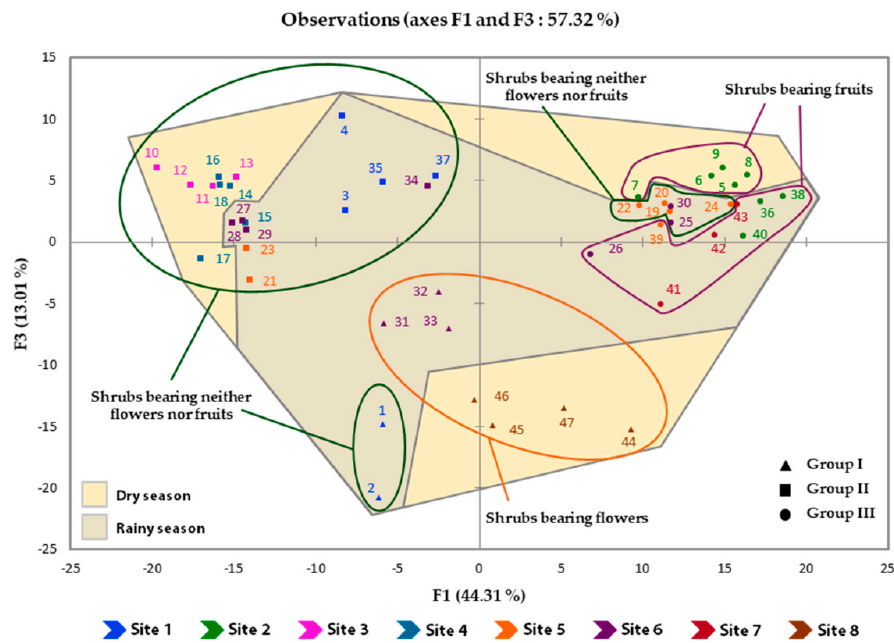
Figure 3. Effect of phenology, season and harvest site on the 47 oil samples’ distribution into